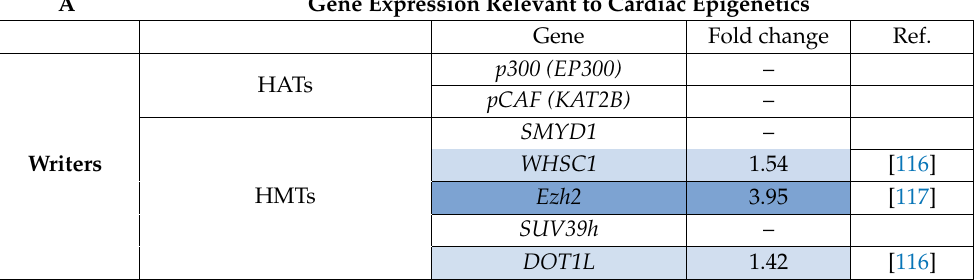
Table 2. Comparative expression illustrating epigenetic profiles ( A ) * and electrophysiology ( B ) for adult human heart (control) and hiPSC-CM. Blue and red coloring indicates degree of relative over- or underexpression in hiPSC-CMs compared to adult human heart. – denotes genes that were not covered by microarray probe sets. AP indicates action potential. Data acquired from